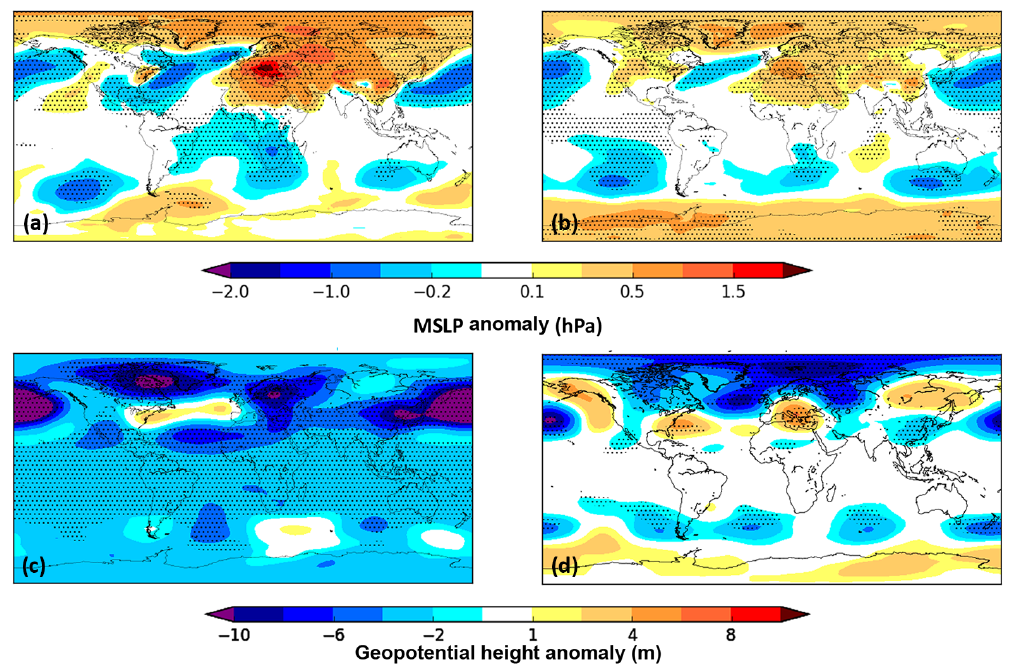
Figure 7. Modifiers of climate in regions outside the areas of anthropogenic land use change. All anomalies are for KK10 − control: (a) JJA MSLP changes at 1850CE, with the stippling indicating grid boxes where the anomalies are significant at the 95% level using Wilcoxon rank sum statistical analysis; (b) as (a) but for 4kaBP; (c) DJF 500Pa geopotential height anomalies at 1850CE demonstrating stationary wave pattern, with the stippling indicating grid boxes where the anomalies are significant at the 95% level using Wilcoxon rank sum statistical analysis; (d) as (c) but for